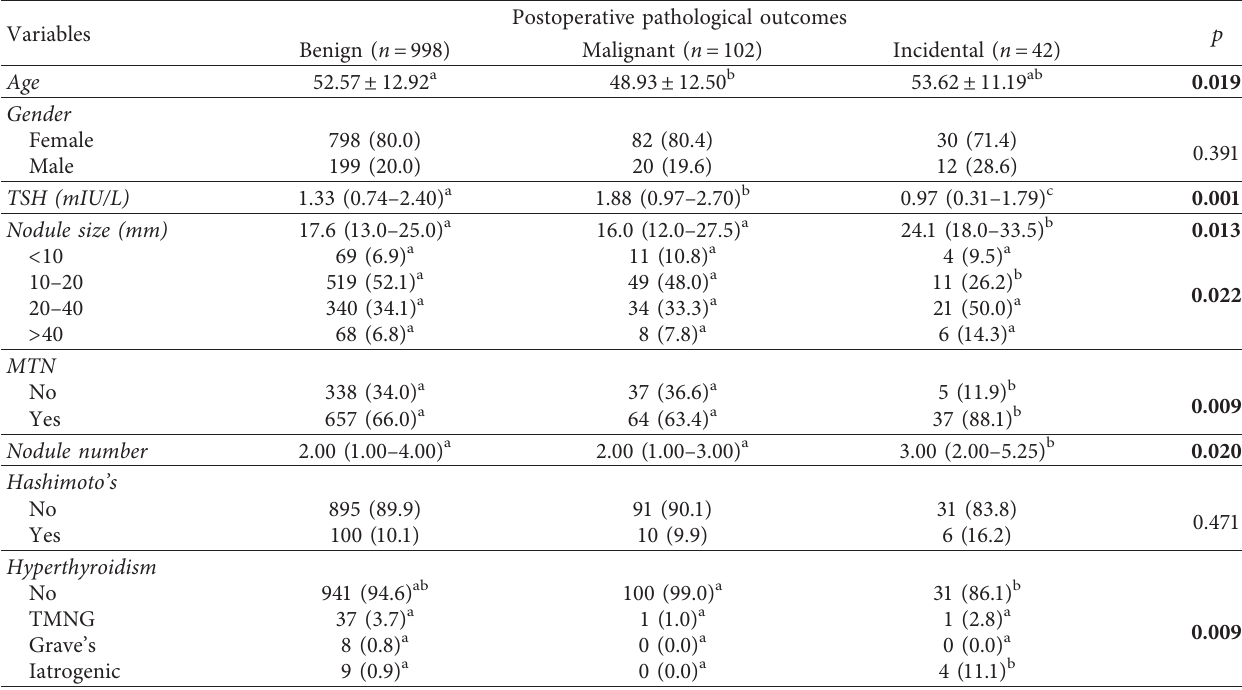
Table 4: Comparison of postoperative pathological outcomes with demographic and clinical